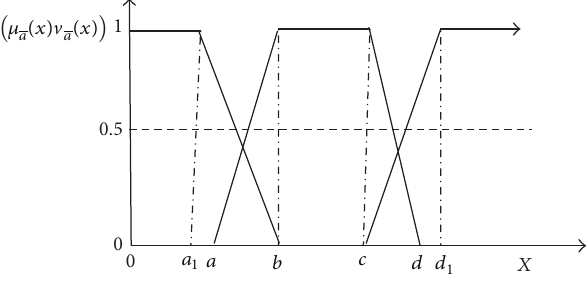
Figure 1: Trapezoidal intuitionistic fuzzy